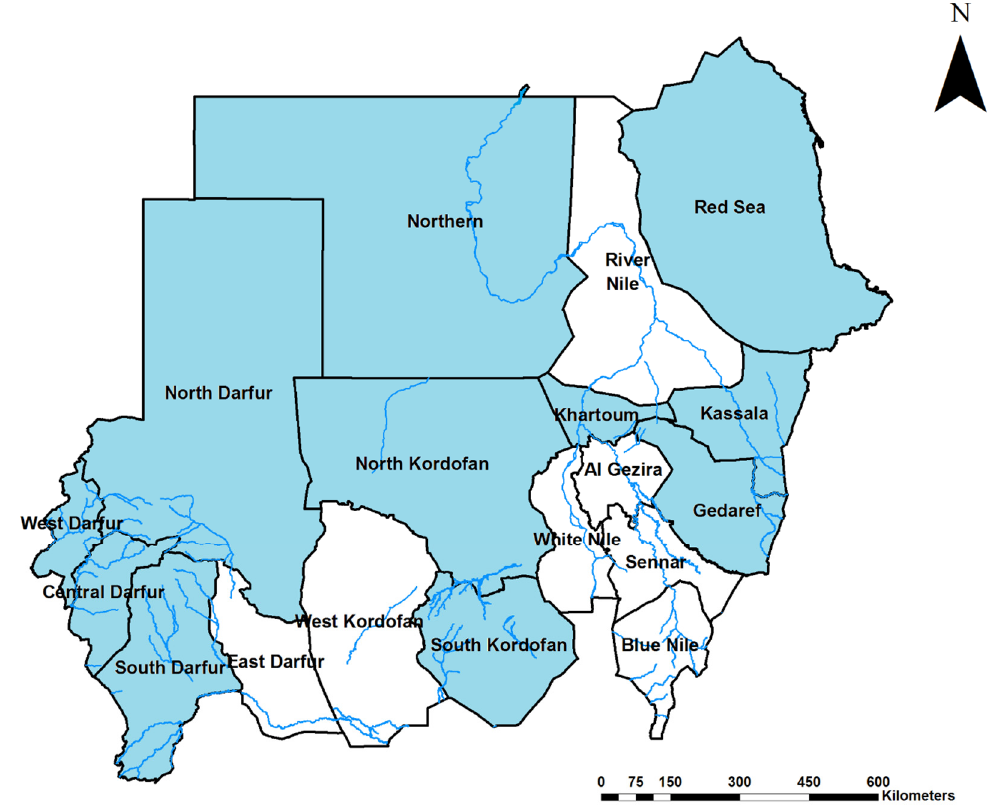
Figure 2. Map of Sudan areas highlighted in light blue indicate states where dengue virus infection has been reported.